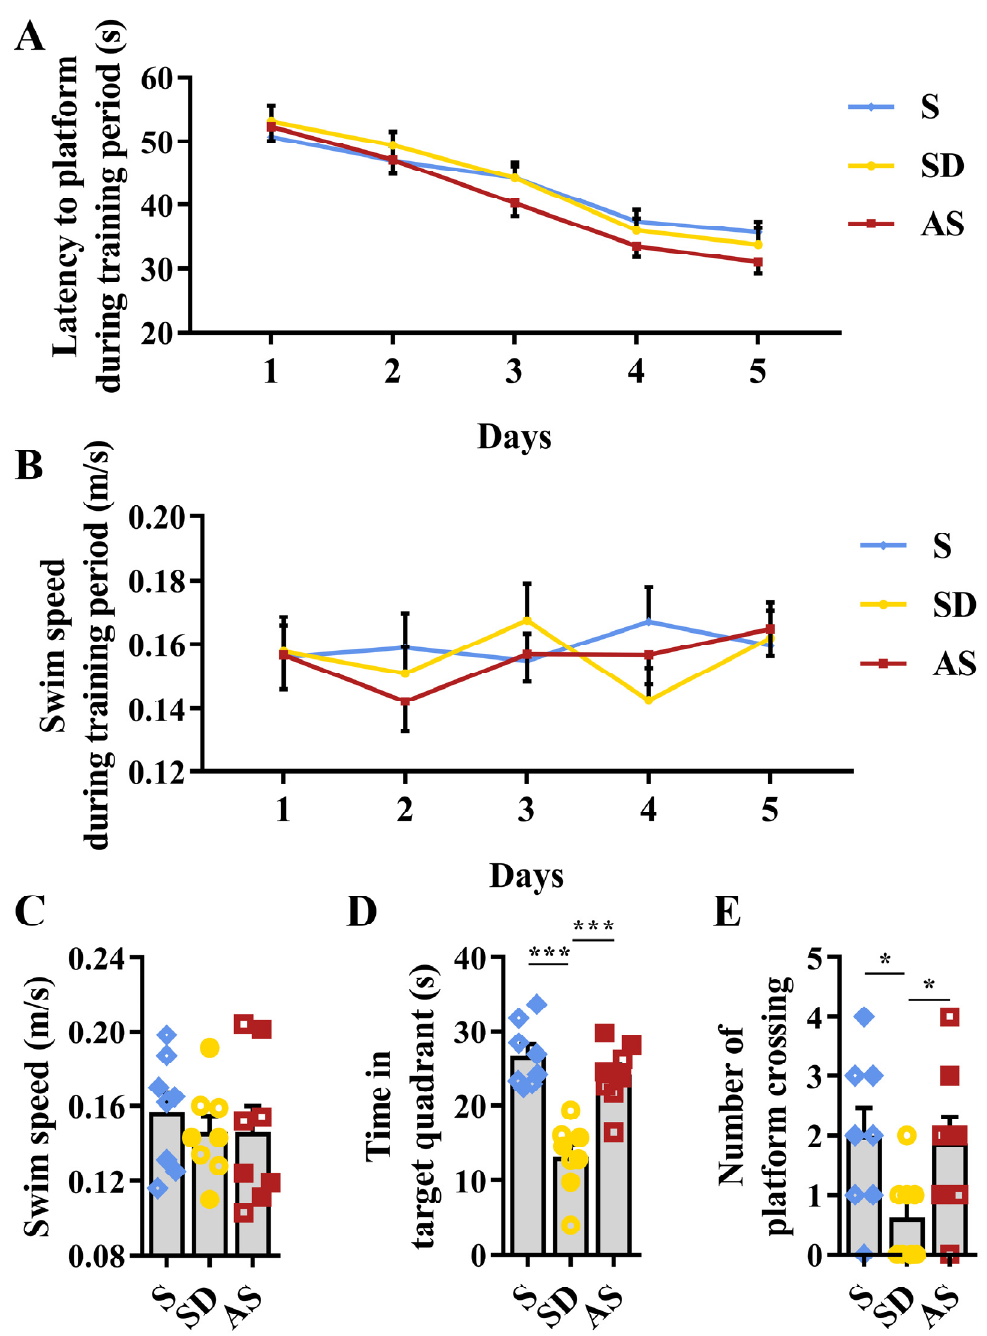
Figure 3. Acoustic stimulation improved spatial memory. ( A ) Latency to reach a hidden platform during the 5-day training period. ( B ) Swim speed during the 5-day training period. ( C ) Swim speed in the probe trial. ( D ) Time spent in the target quadrant in the probe trial. ( E ) The number of crossings of the original platform-site in the probe trial. One-way ANOVA followed by two-sample LSD t tests is used. Data are expressed as mean ± SEM. Closed dots constitute male mice, and open dots constitute female mice. * p < 0.05, *** p <